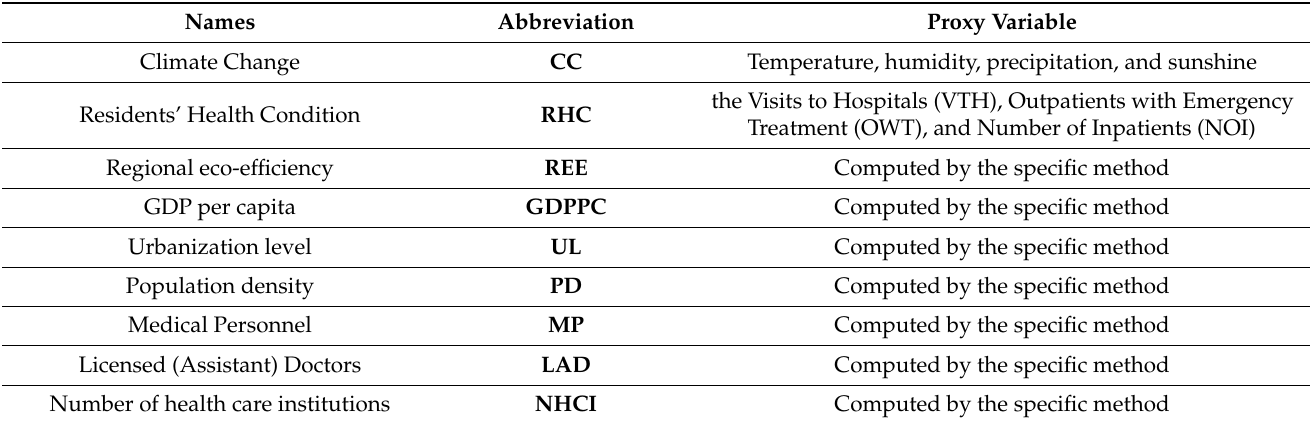
Table 1. Variable name and